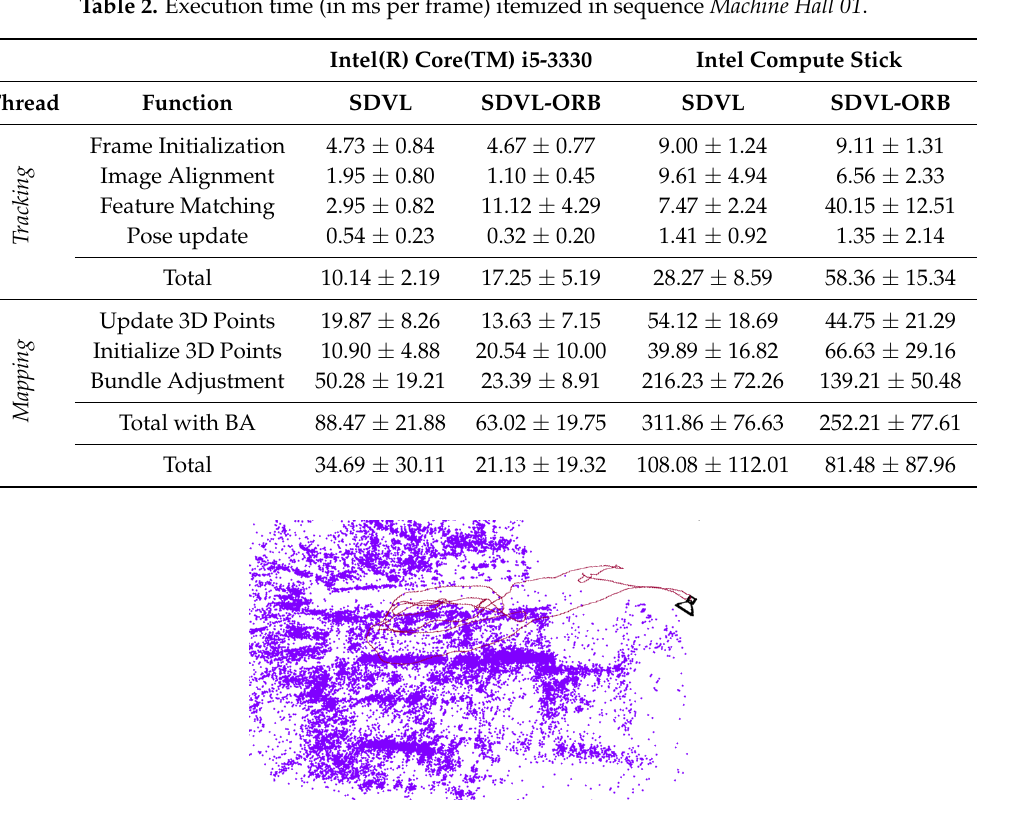
Figure 6. 3D map created in sequence MH01 with SDVL-ORB.